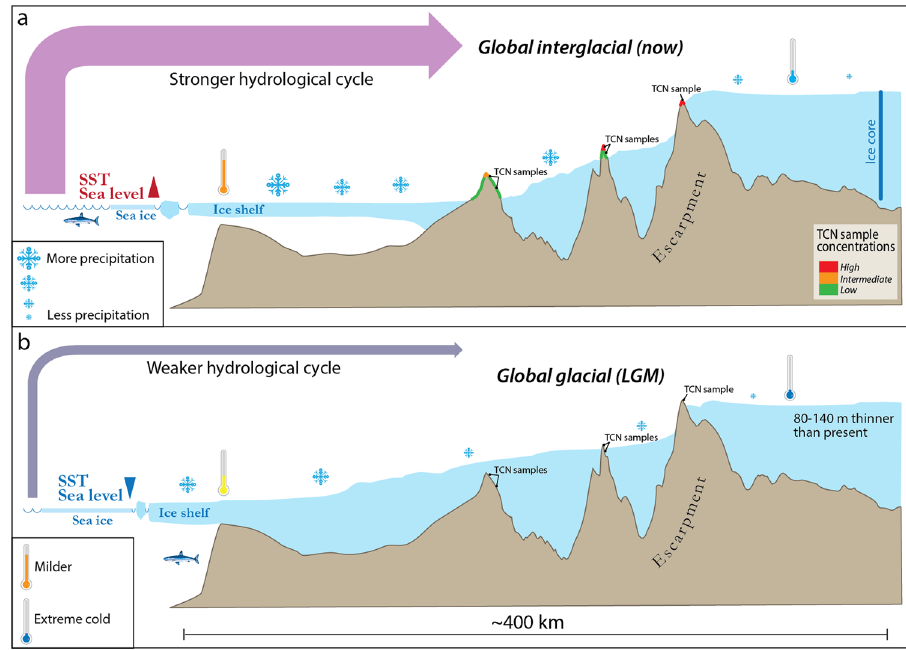
Fig. 5 Conceptual fi gure of DML escarpment hinge-zone. Schematic diagram of ice-climate-escarpment interactions during global a interglacials and b glacials across a N-S section of Dronning Maud Land. During global interglacials ( a ) sea- surface temperatures (SST) and sea level increase while sea-ice extent shrinks, and the grounding line retreats. As a result, increased evaporation leads to increased precipitation and inland ice thickness. In contrast, ice- core records (illustrated in a) indicate interior ice thinning during global glacial periods ( b ), when SST and sea level are lower, the grounding line advances, and sea ice is more extensive resulting in lower evaporation and precipitation. Cosmogenic nuclide inversions in this paper indicate that the escarpment acts as a hinge-zone where ice-dynamical changes resulting from grounding line migration taper off inland, and, inversely, inland precipitation-driven changes taper off towards the